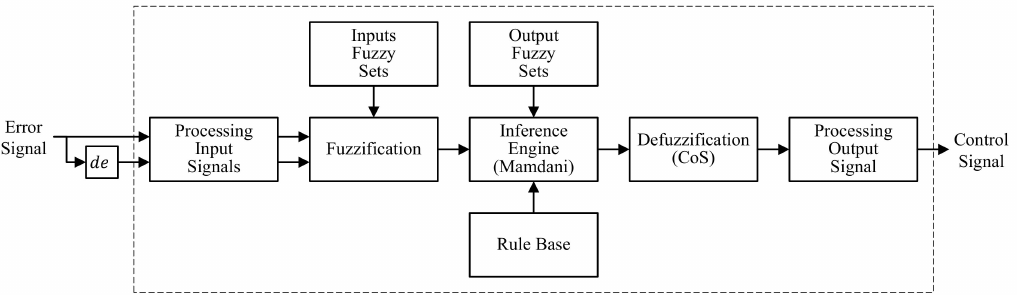
Figure 13. Block diagram of the